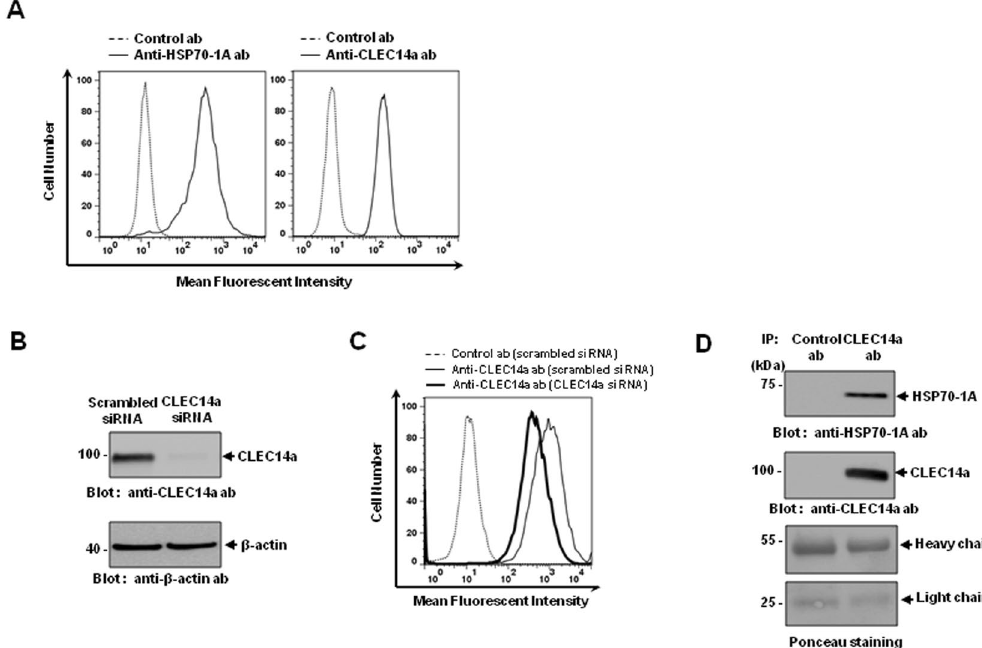
Figure 2. Specific interaction of HSP70-1A with CLEC14a on HUVECs. ( A ) The coexistence of HSP70-1A and CLEC14a on the surfaces of HUVECs was measured by flow cytometry with control antibody (dashed line) or anti-HSP70-1A and anti-CLEC14a antibody (solid line). ( B ) Representative immunoblots show the expression of CLEC14a or β -actin from scrambled siRNA- or CLEC14a siRNA-treated HUVECs. ( C ) CLEC14a on the surface of HUVECs was compared using flow cytometry in presence of control antibody (dashed line) or anti- CLEC14a antibody in scrambled (thin line) siRNA-treated HUVECs or anti-CLEC14a antibody in CLEC14a (thick line) siRNA-treated HUVECs. ( D ) Proteins were co-immunoprecipitated with control antibody or anti- CLEC14a antibody and immunoblotted with anti-HSP70-1A or anti-CLEC14a antibody as designated. The heavy and light chains of the control antibody or anti-CLEC14a antibody were used as a loading control and were stained with Ponceau stain. The results shown are representative of three independent